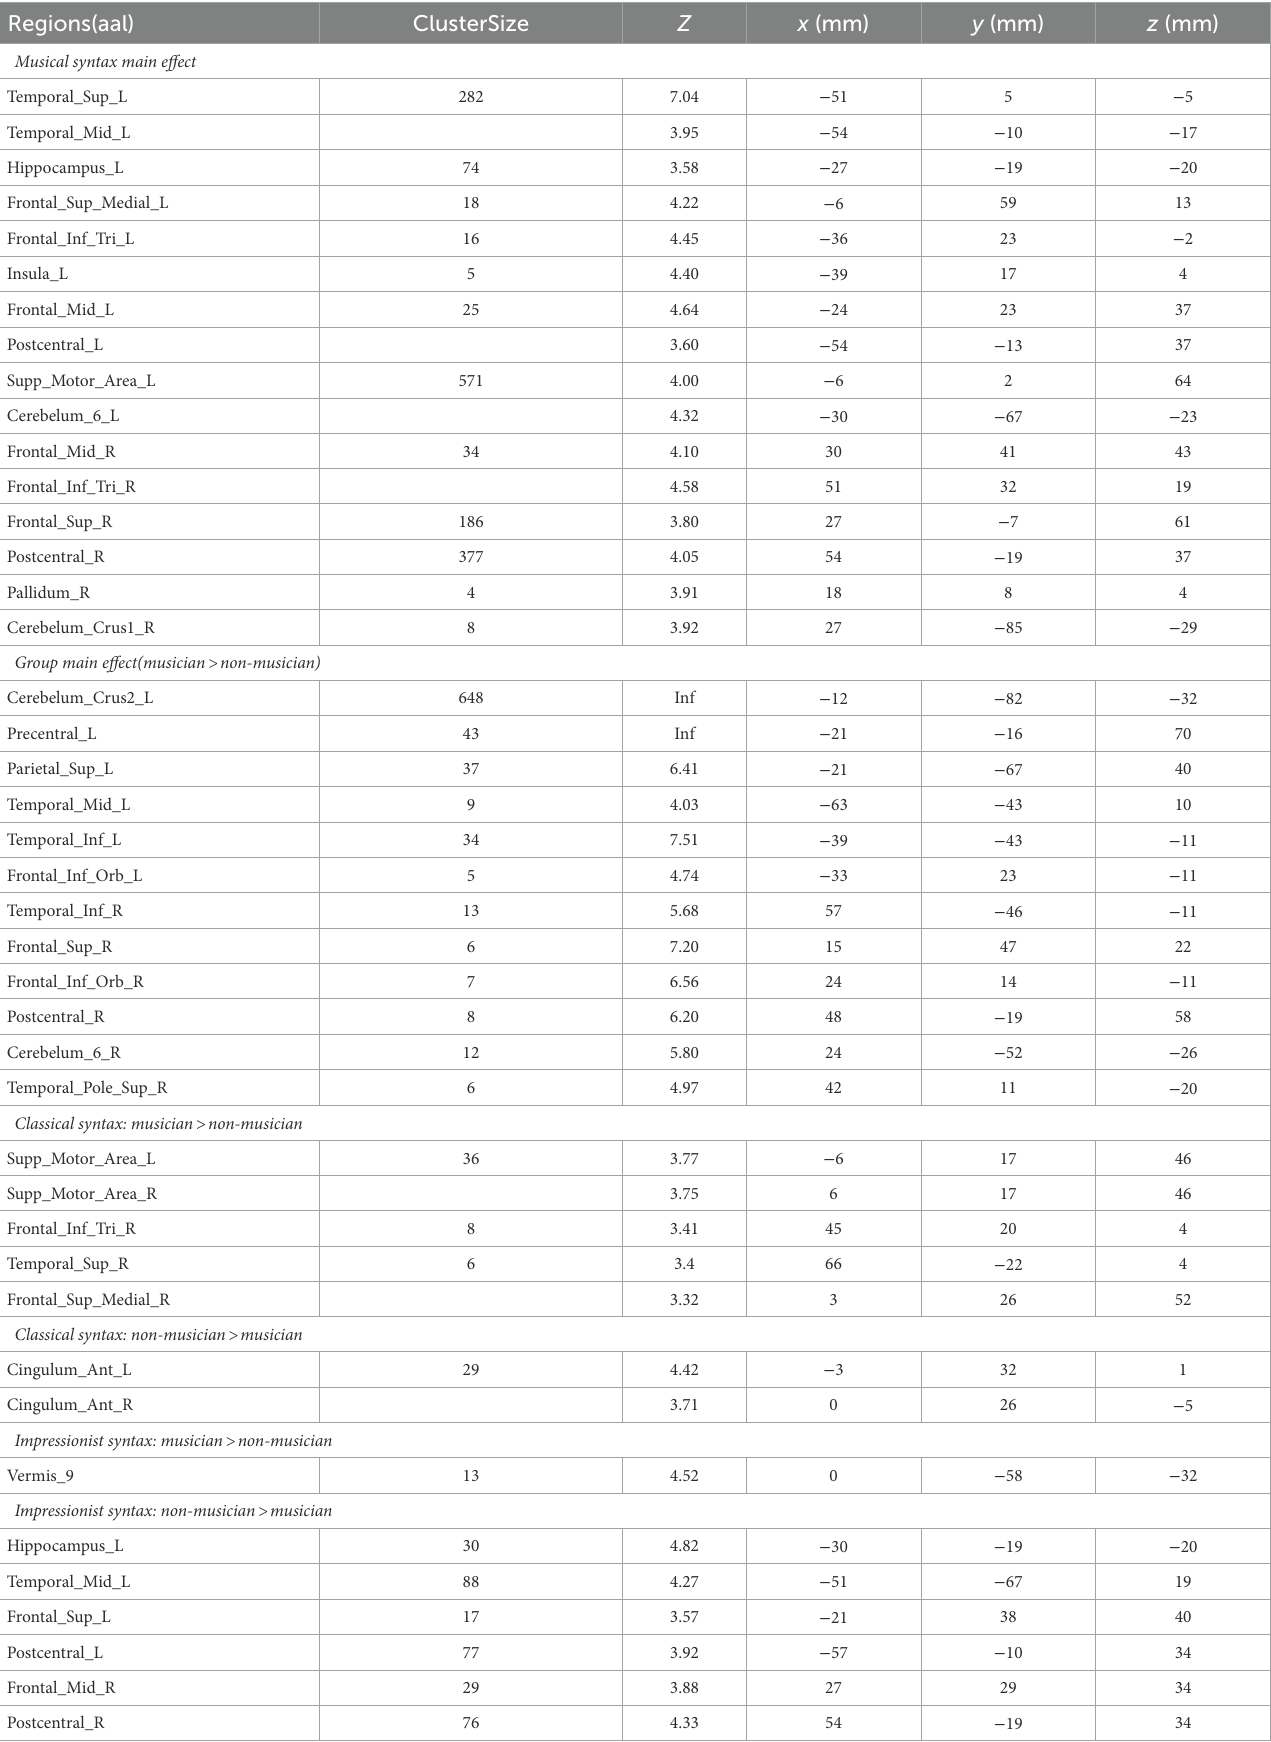
TABLE 2 Activation results of main effects of musical syntax and group, and simple effects of musicianship on classical and impressionist music processing (all alphasim corrected at p < 0.001). Regions(aal) ClusterSize Z x (mm) y (mm) z (mm) Musical syntax main effect